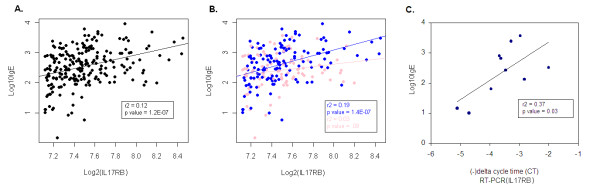
The Correlation Between CD4+ Lymphocyte Measurement of IL17RB and Serum IgE. Figure 1A and 1B represent plots of log2-transformed gene expression measurement of IL17RB (on the x-axis) vs. log10-transformed total serum IgE measurement (on the y-axis), with regression lines, for all subjects without (1A) and with (1B) consideration of male (in blue) and female (pink) sex. Figure 1C represents a plot of the (-) delta cycle time from the real time-polymerase chain reaction of measurement of IL17RB (on the x-axis) vs. log10-transformed total serum IgE measurement (on the y-axis) in all subjects.